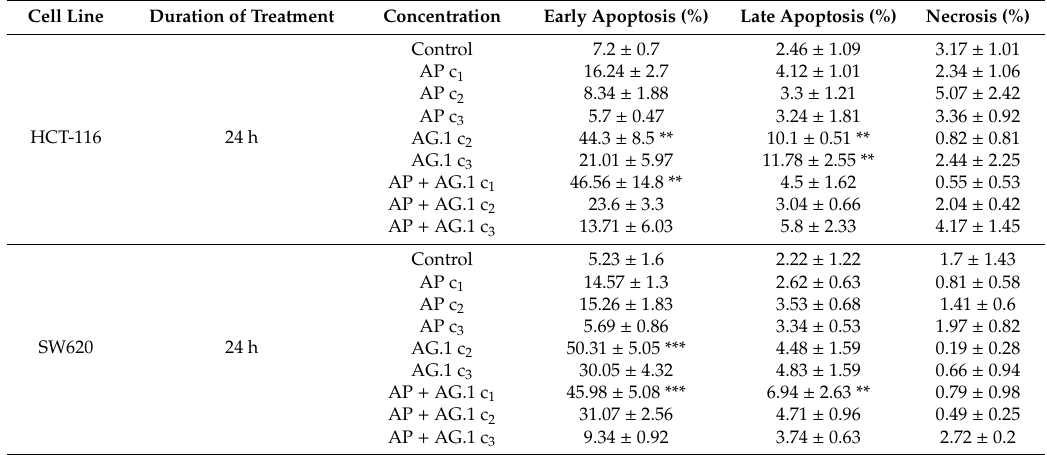
Table 2. Induction of apoptosis in HCT-116 and SW620 cells after treatment with Agarikon Plus